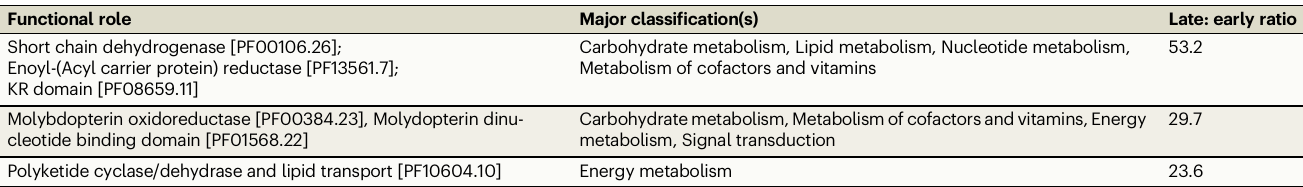
Table 2 | Functional roles that exhibited strong seasonality with transcript enrichment by more than 20-fold in the late season than early Functional